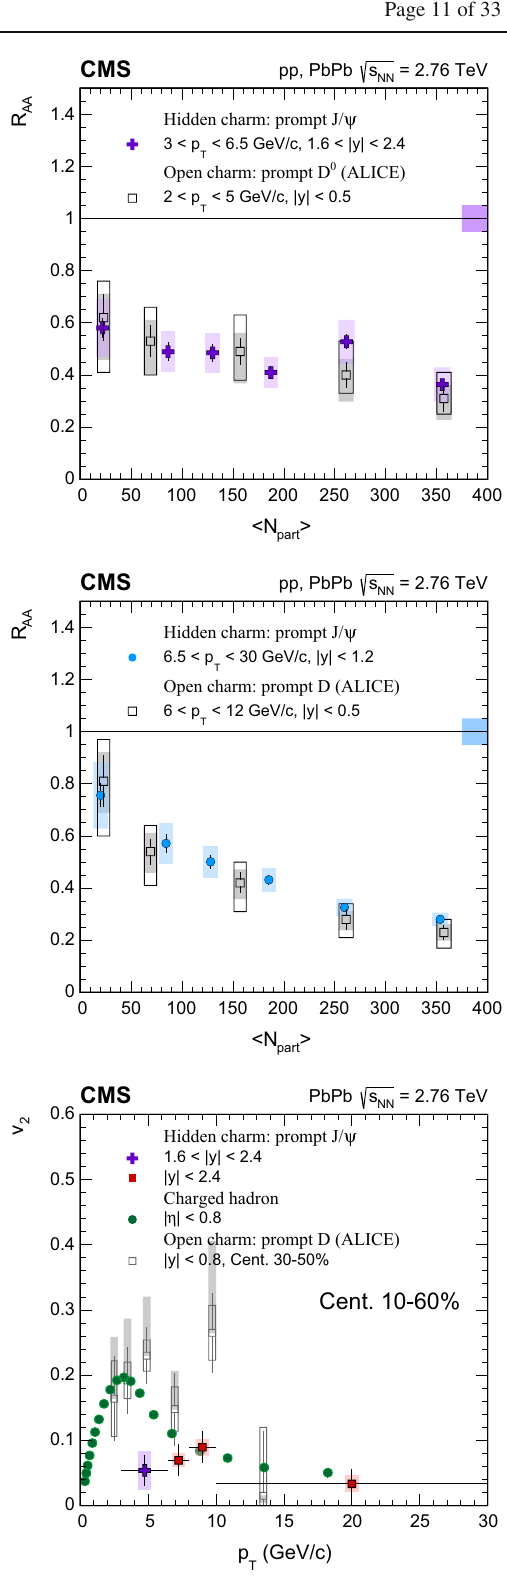
Fig. 9 Prompt J /ψ and D meson [61] R AA vs. centrality for low p T ( top ) and high p T ( middle ). The average N part values correspond to events flatly distributed across centrality. Bottom Prompt J /ψ and D meson [31], and charged hadron [58,60] v 2 vs. p